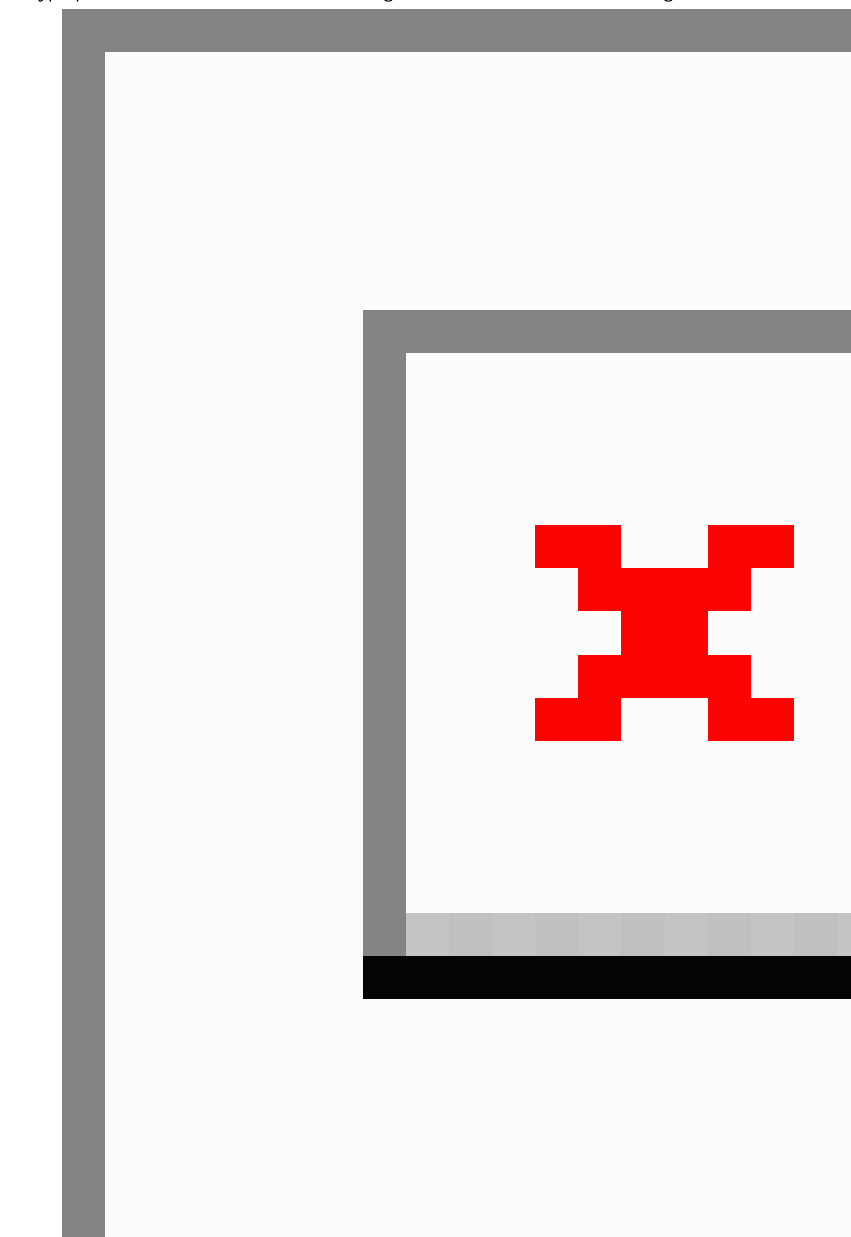
Figure 2. The concept of support vector machine (SVM) methodology is transferring the vectors (ie, cases) to a higher dimension. The optimal linear hyperplane could be obtained from the largest distances between the 2